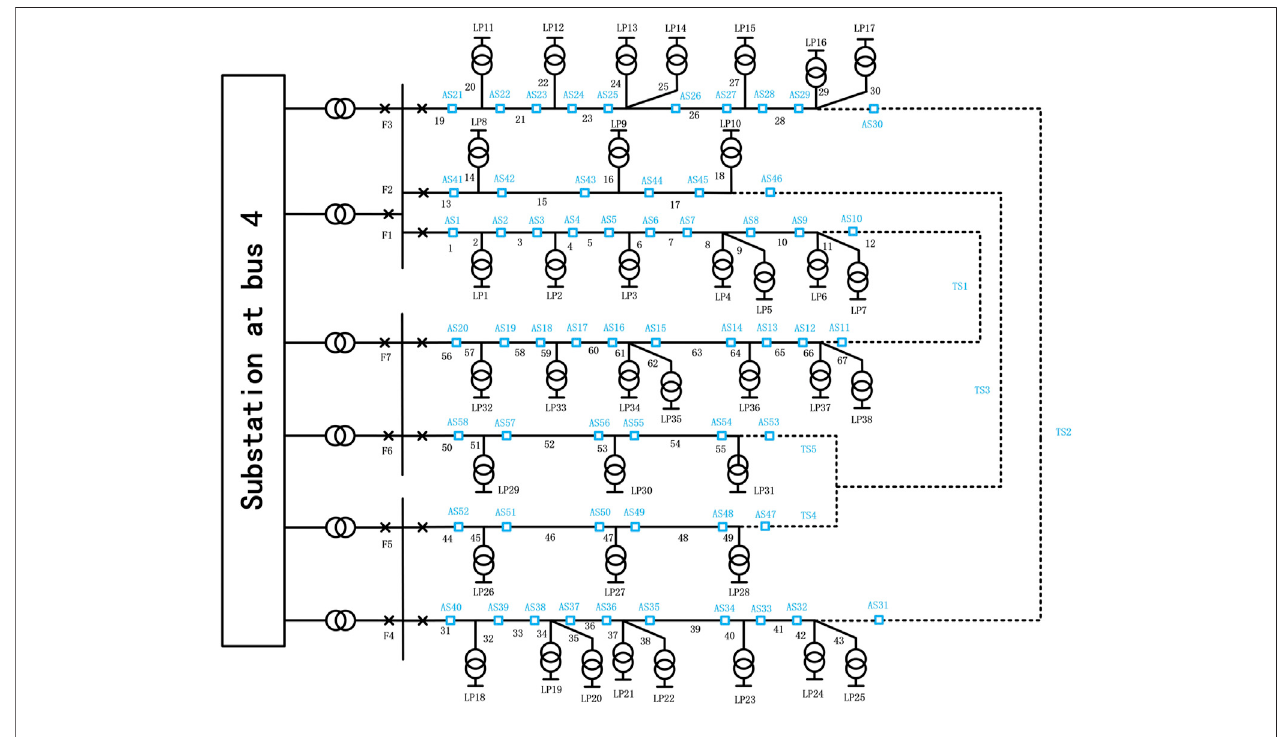
FIGURE 5 | Bus 4 of the Roy Billinton test system.